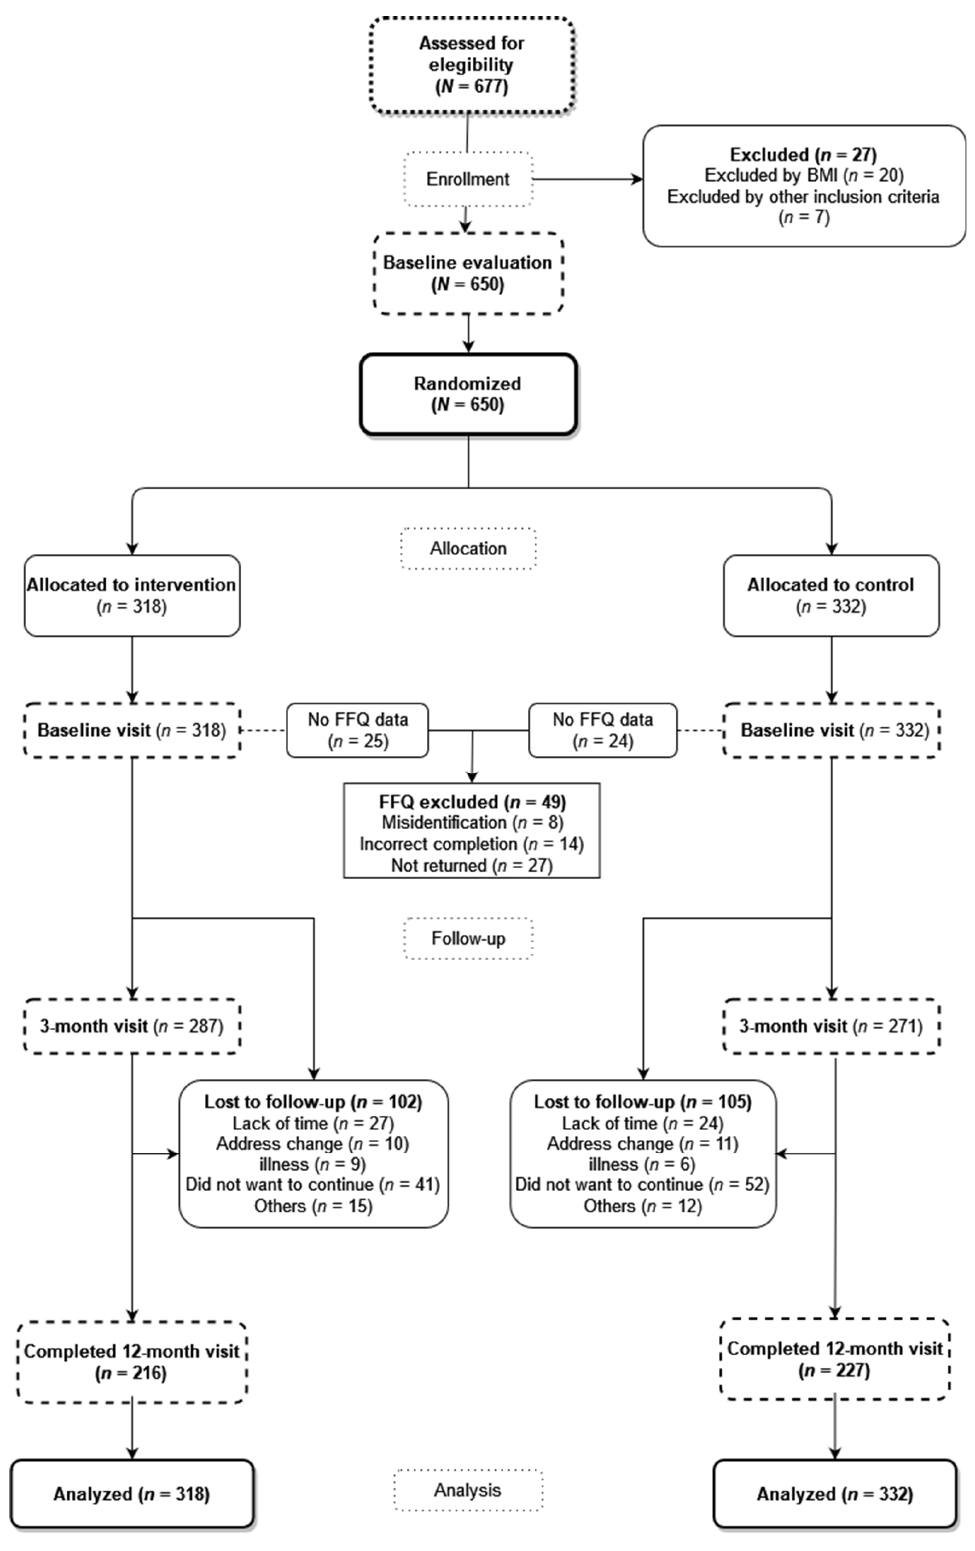
Figure 1. Flowchart of the study. FFQ: Food Frequency Questionnaire.